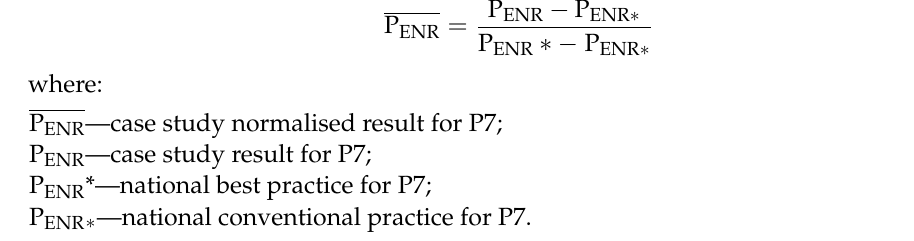
Table 1. Conversion from the quantitative to the qualitative performance scales in SBTool PT -H. Qualitative Level Quantitative Value A+ p > 1.00 A 0.70 < p ≤